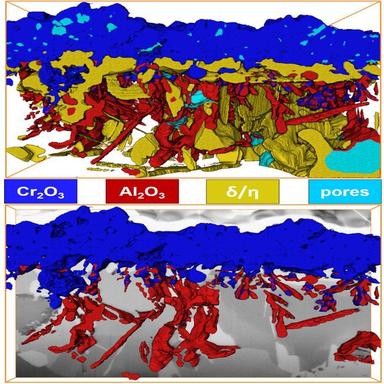
(A) 3D tomographic reconstruction of the microstructural features of the near-surface area (front view); B) the same image as 12A, but limited to Cr2O3 and Al2O3, with an orthoslice inserted at a distance of 3 μm along the zaxis.